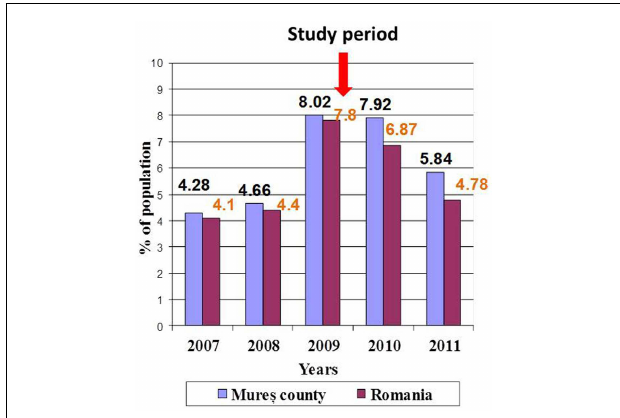
FIGURE 1 | Unemployment rate during economic crisis 2007–2011 .